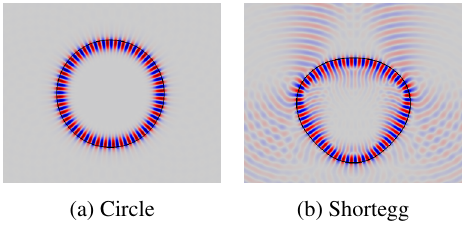
Figure 1: Comparison of the mode structure